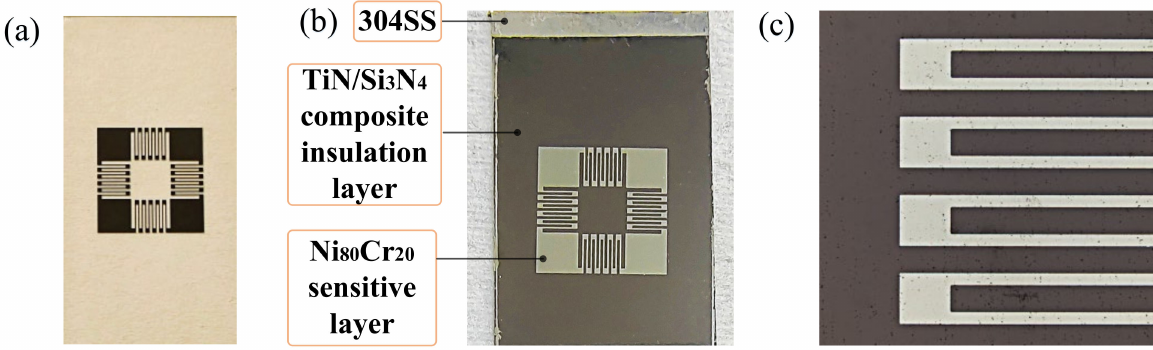
Figure 1. ( a ) The four thin-film resistor grids are connected into “Ring-shaped” Wheatstone bridge circuits. ( b ) Thin-film force sensor. ( c ) Partially enlarged image of resistance grid.